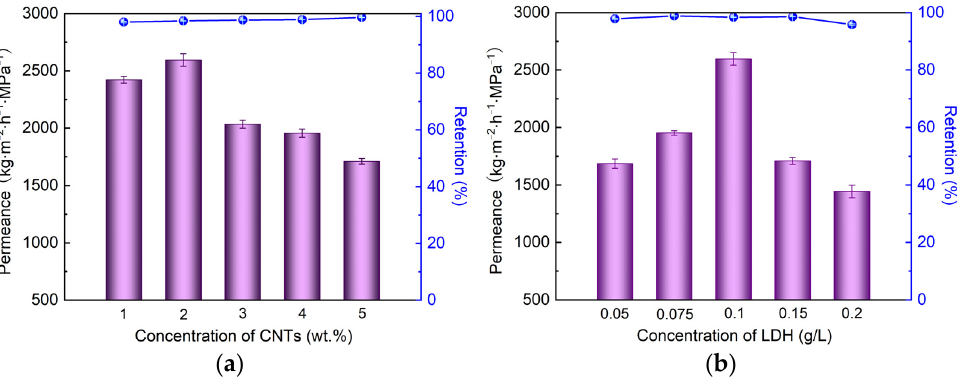
Figure 6. ( a ) The effects of CNTs concentrations on the separation performance (operation condition: 0.1 g/L Evans blue aqueous solution; operating pressure: 0.1 MPa); ( b ) the effects of LDH concentrations on separation performance (operation condition: 0.1 g/L Evans blue aqueous solution; operating pressure: 0.1 MPa).